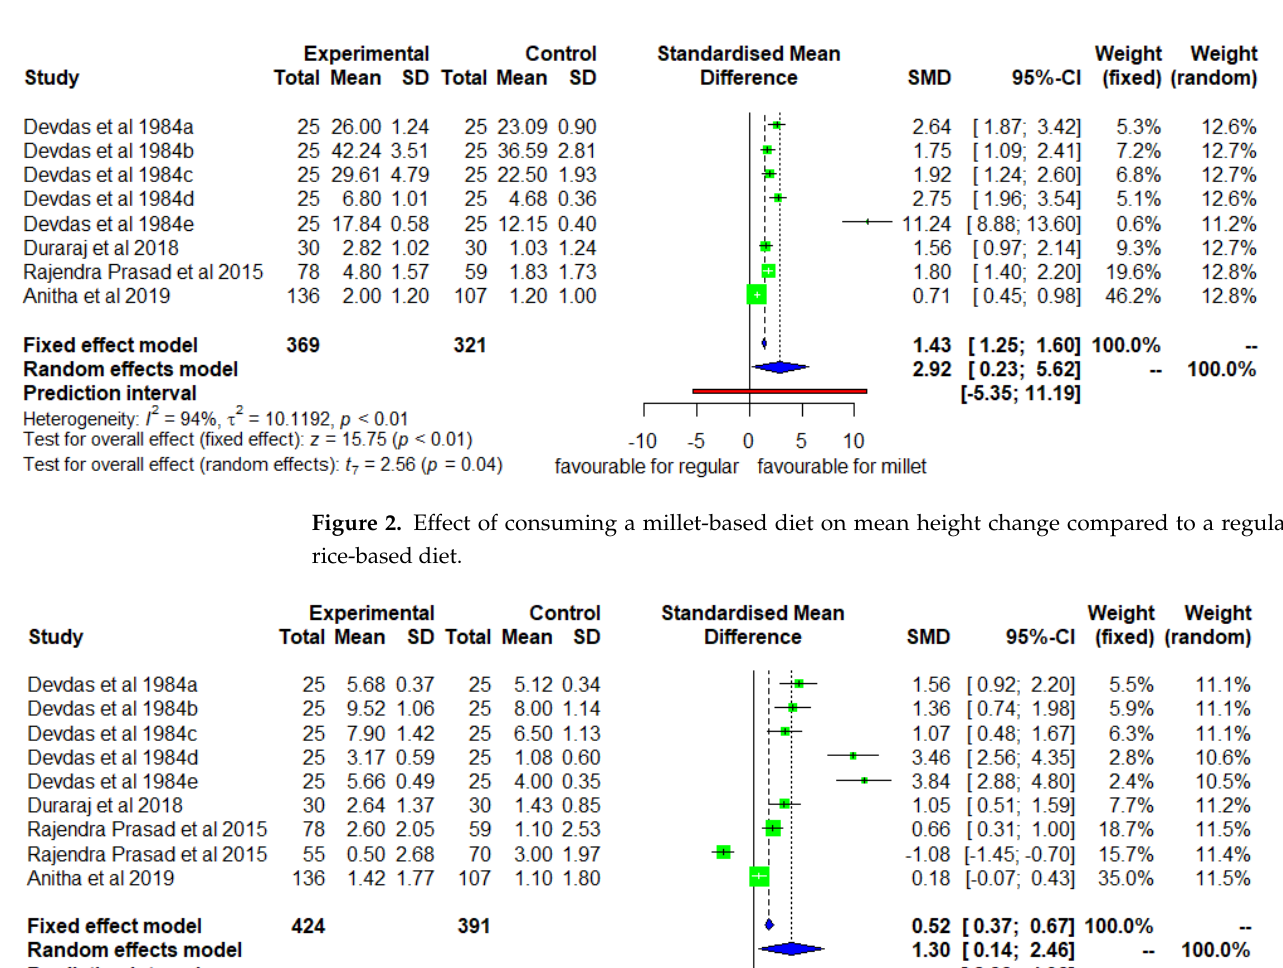
Figure 3. Effect of consuming a millet-based diet on mean weight change compared to a regular rice-based diet.